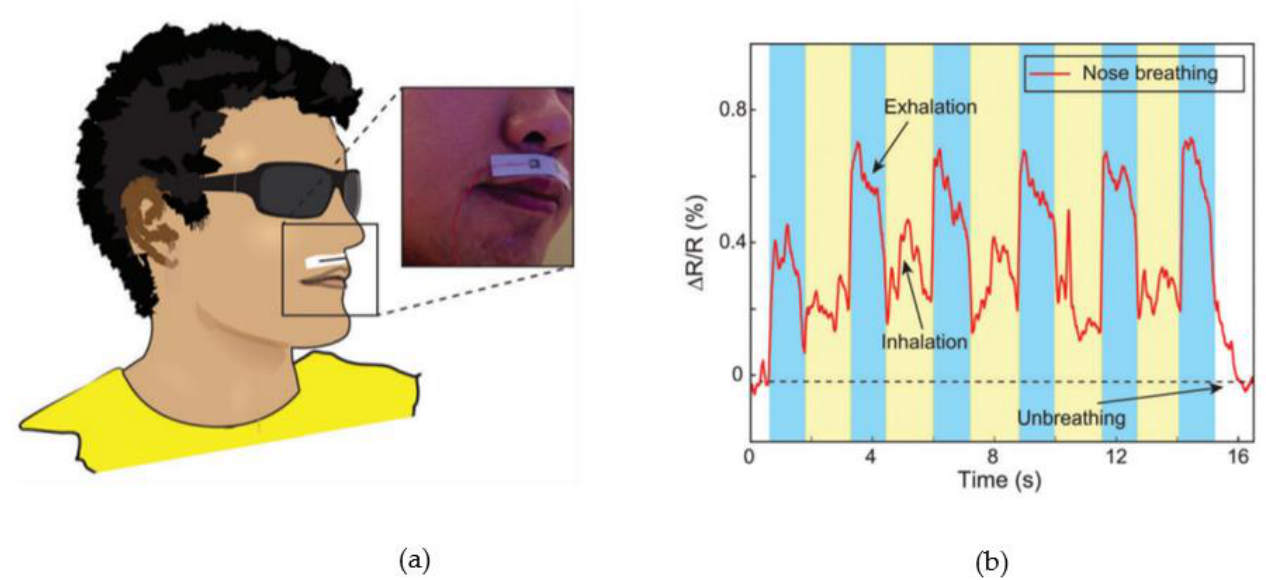
Figure 3. A picture of a patient wearing a flexible respiratory disease monitoring sensor (humidity sensor), reprinted with permission from [26].( a ) Flexible respiratory sensor attached to a person’s nose for monitoring.( b ) Output from the flexible respiratory sensor showing distinct peaks for inhalation and exhalation.